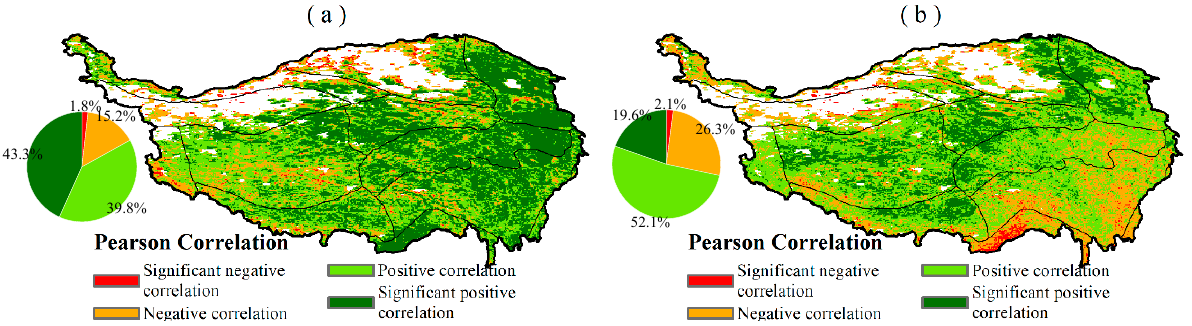
Figure 5. Spatial patterns of the Pearson correlations between AVHRR NDVI and temperature ( a ) and precipitation ( b ) on the QTP from 1982 to 2019.